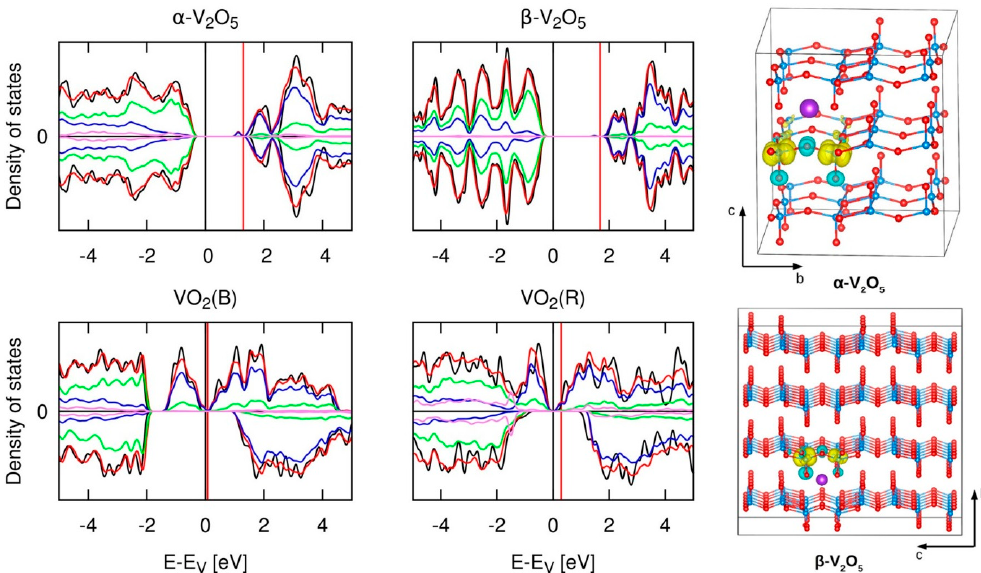
Figure 10. Left : Spin-polarized density of states for pristine (black line) and K-inserted (red line) α -V 2 O 5 , β -V 2 O 5 , VO 2 (R), and VO 2 (B) compounds. Contributions are resolved by atom type, which are indicated by different colors: blue (V), green (O) and purple (K, scaled by 100). Spin-up has a positive, spin-down density of states a negative sign. Energies are given relative to the valence band edge (or metallic Fermi level) and the relative positions of the Fermi levels are indicated by vertical lines. Right : Spin density difference displaying the “ladder effect” in α -V 2 O 5 and β -V 2 O 5 . Reprinted with permission from [31], © (2017) Cambridge University Press.